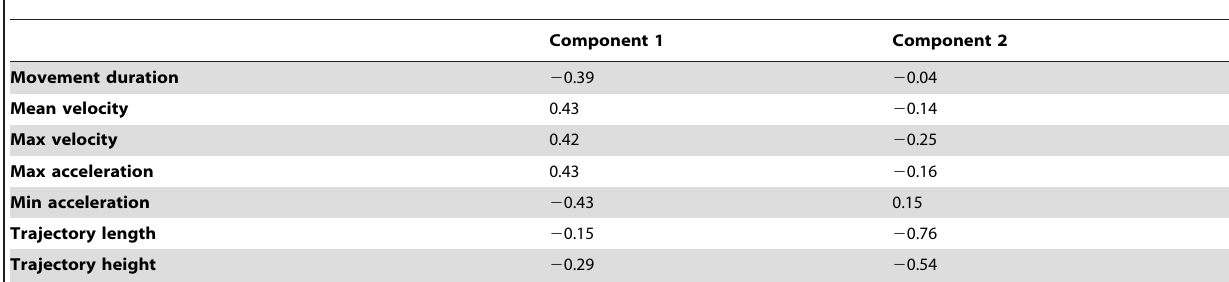
Table 1. Coefficients of the kinematic parameters for the first two